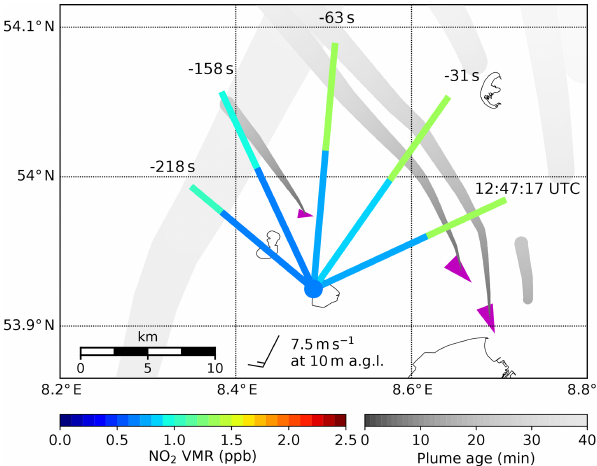
Figure 7. Map showing a zoom in onto panel 15 of Fig. 6 and also the four previous MAX-DOAS observations, which were measured between 30s and 3.5min before the current observation. Horizontal light path lengths and corresponding path-averaged volume mixing ratios of NO 2 are shown as colored lines and the in situ NO 2 VMR as a colored dot at the location of the instrument. Magenta triangles show the ship position and course, with larger triangles for larger ships. The modeled plumes are shown in gray, with the lightness of the gray shading representing the plume age. The broader plume in the eastern part of the map originates from the Wilhelmshaven power plants. Please keep in mind that ship and plume position were different for the past measurements. Wind direction and speed are shown with a meteorological wind barb.